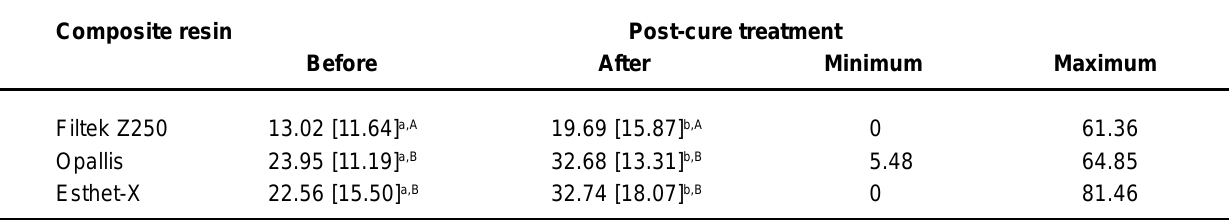
Different lowercase letters in the rows and uppercase letter in the columns indicate statistically significant